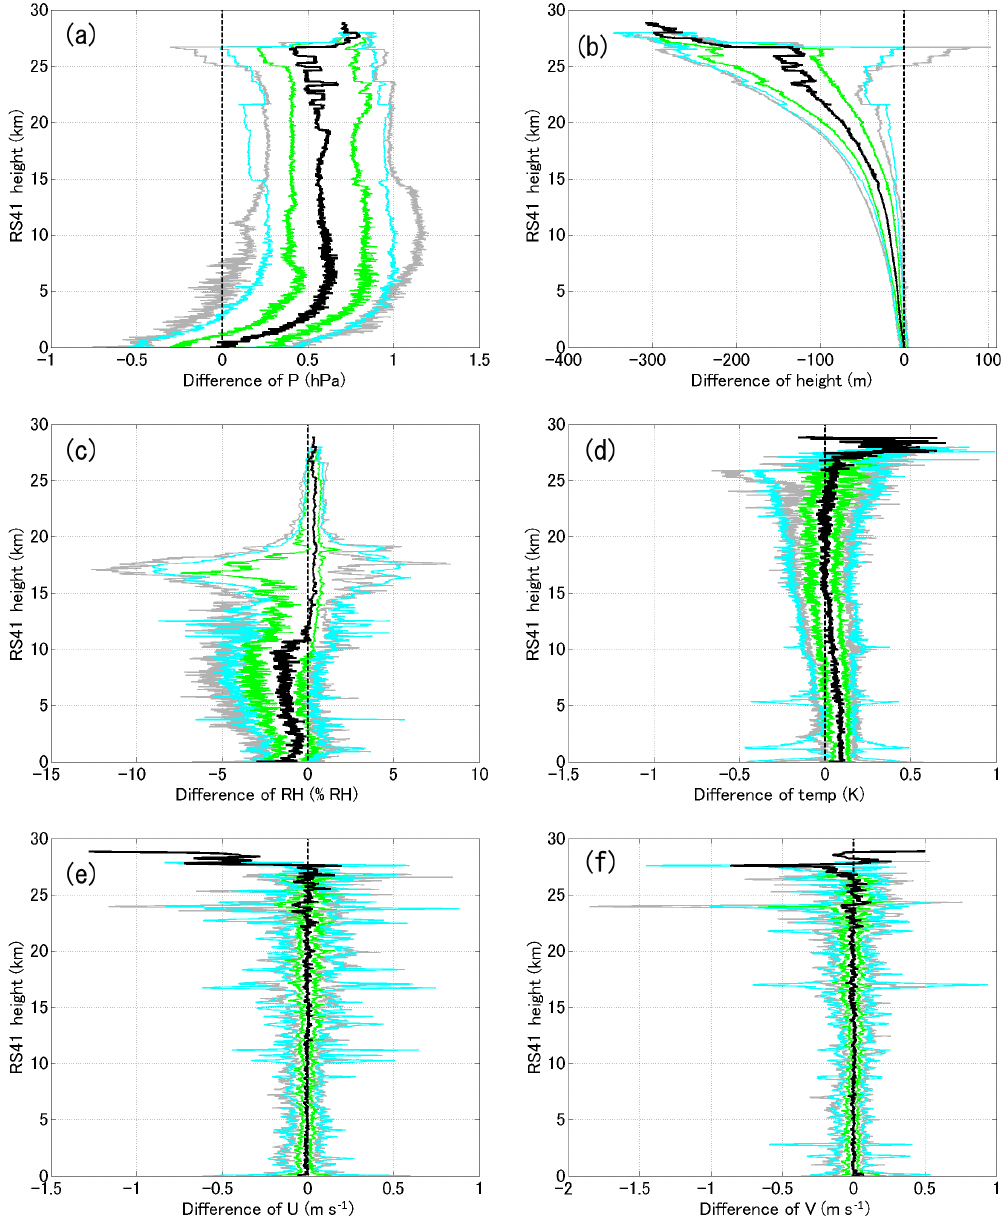
Figure 3. Vertical profiles of the median (black), 25–75th percentile (green), 10–90th percentile (gray), and mean ± standard deviation (cyan) of all differences between the RS92 and RS41 observations (RS92–RS41) for (a) pressure, (b) geopotential height, (c) relative humidity, (d) temperature, (e) zonal wind, and (f) meridional